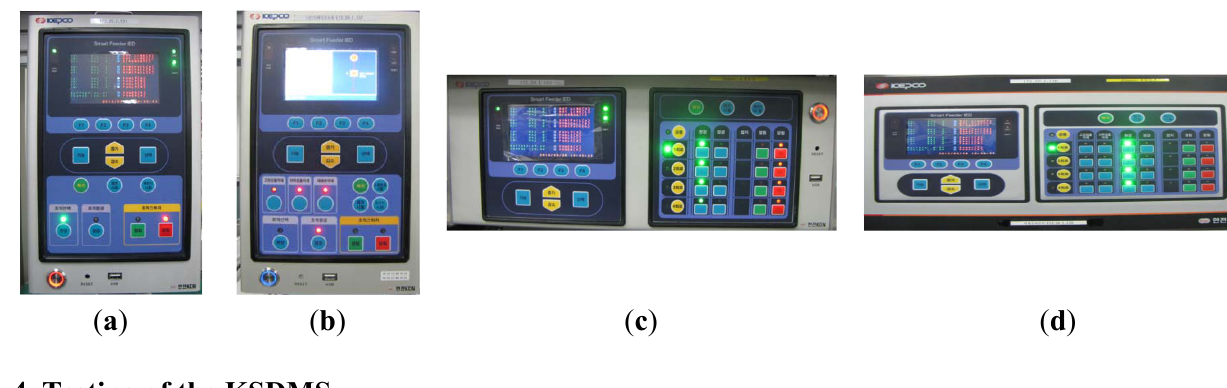
Figure 10. Developed field IEDs, based on IEC61850: ( a ) overhead switch; ( b )